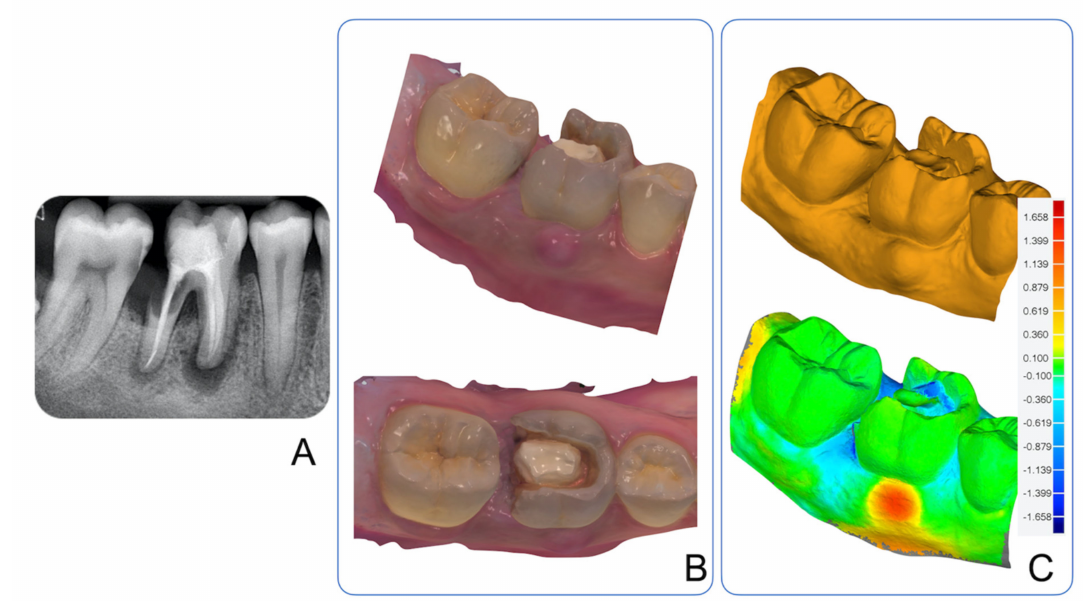
Figure 1. ( A ) Periapical radiograph of lower right posterior teeth demonstrating multiple periapical and radicular radiolucencies associated with endodontically treated tooth 46 and a mesial coronal radiolucency on tooth 47. ( B ) Intraoral scan of lower right posterior teeth demonstrating a dental abscess and failing restoration. ( C ) 3D-deviation analysis comparing intraoral scans pre and post abscess